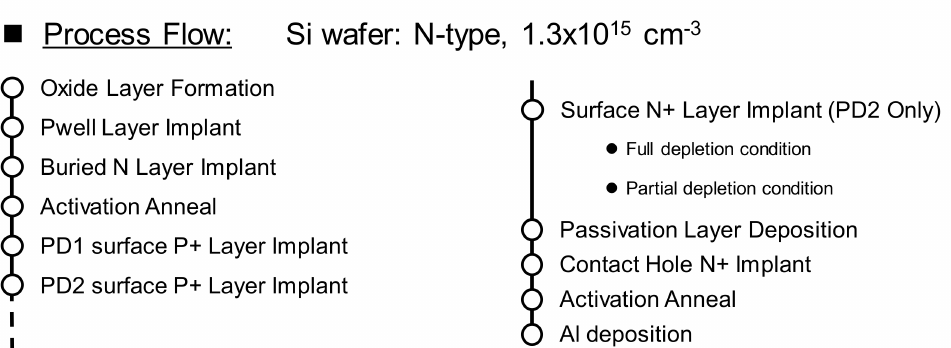
Figure 5. Process flow used in the simulations and manufacturing of the photodiodes.